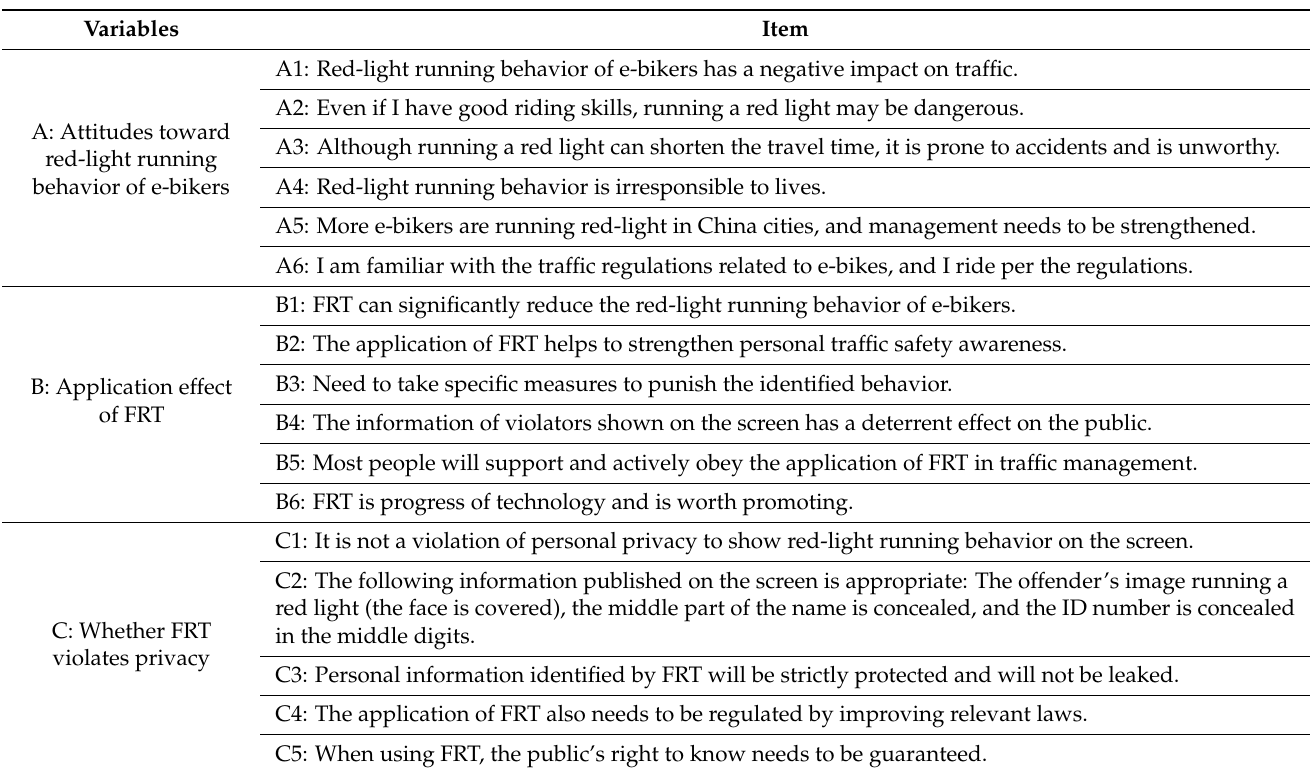
Table 2. Survey items of public and traffic police attitudes toward